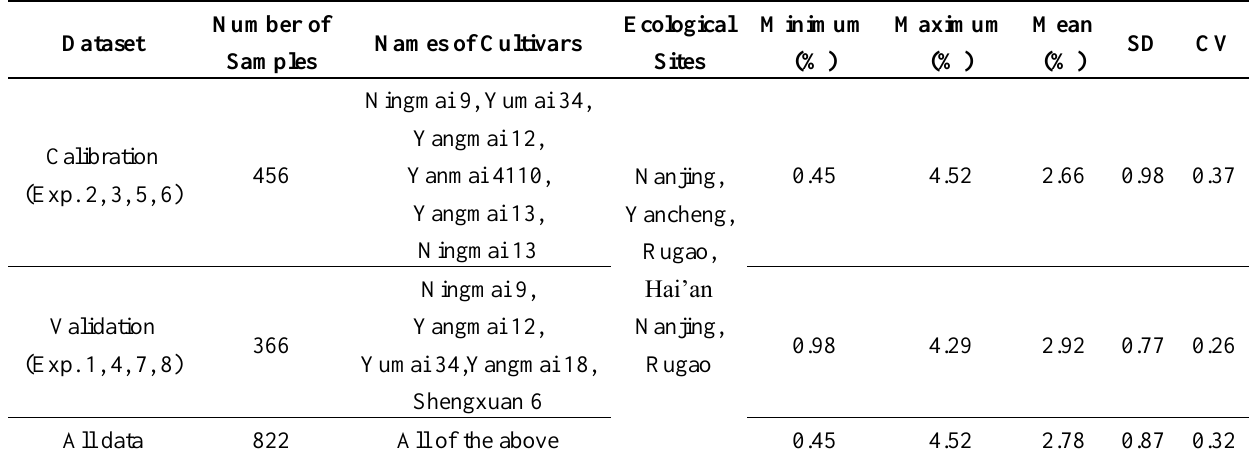
Table 2. The statistical parameters of the calibration and validation sets for the wheat leaf nitrogen content